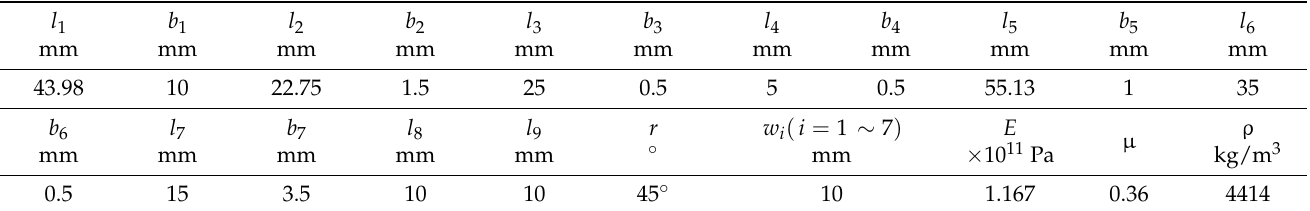
Table 1. Key parameters for